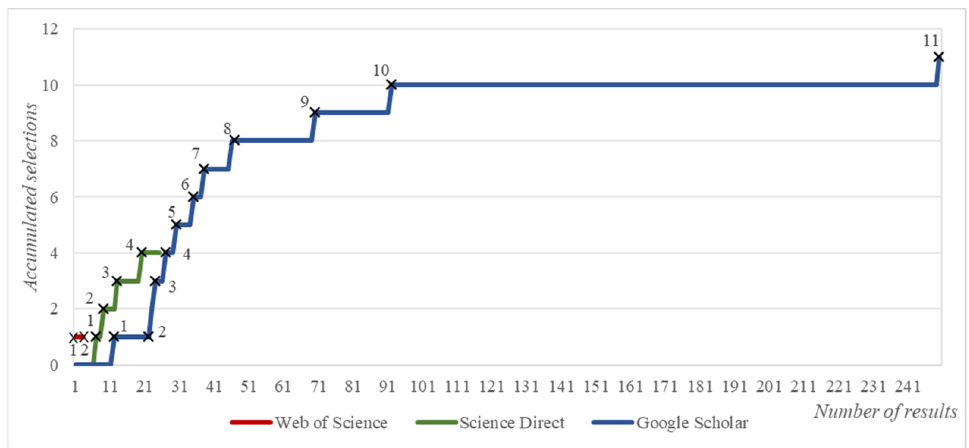
Figure 3. The overall selections of scientific papers from the total results of the three databases.